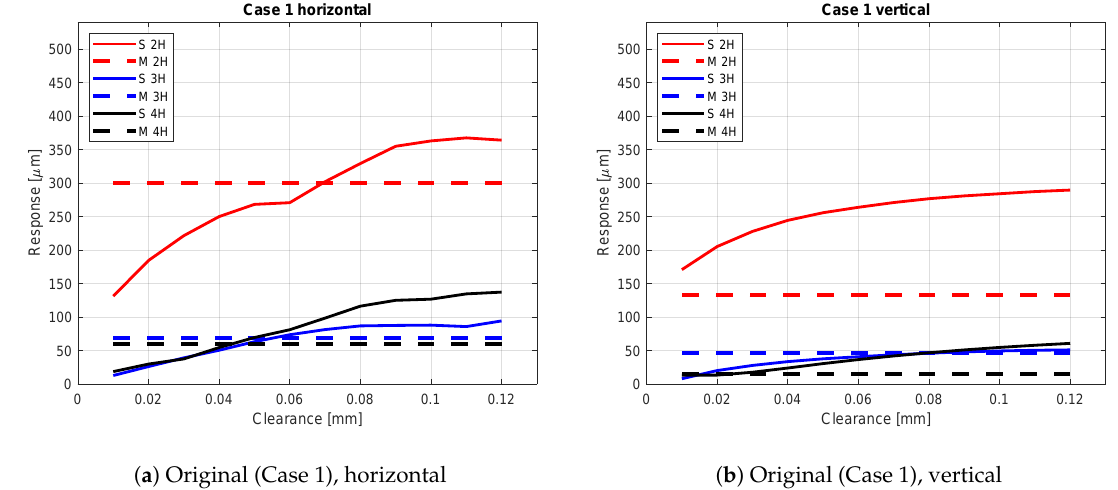
Figure 11. Case 1—original bearing inner ring roundness profile in the service end. Simulated rotor resonance peak amplitudes at subcritical resonance frequencies with varying bearing clearance from 0.01 mm to 0.12 mm. The dashed lines show the measured value. S 2H refers to the simulated second harmonic component, whereas M 3H refers to the measured third harmonic component.